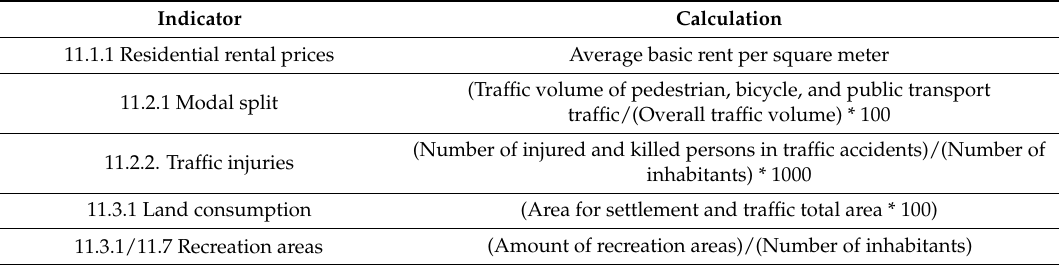
Table 2. Targets and indicators of Sustainable Development Goal (SDG) 11 developed in the project “SDG Indicators for